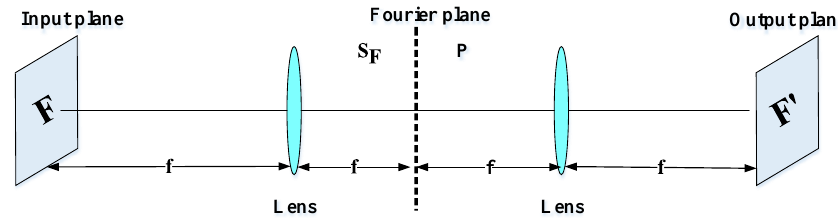
Figure 4. All “4f” optical configuration Figure 4. All “ 4f ” optical configuration [37].